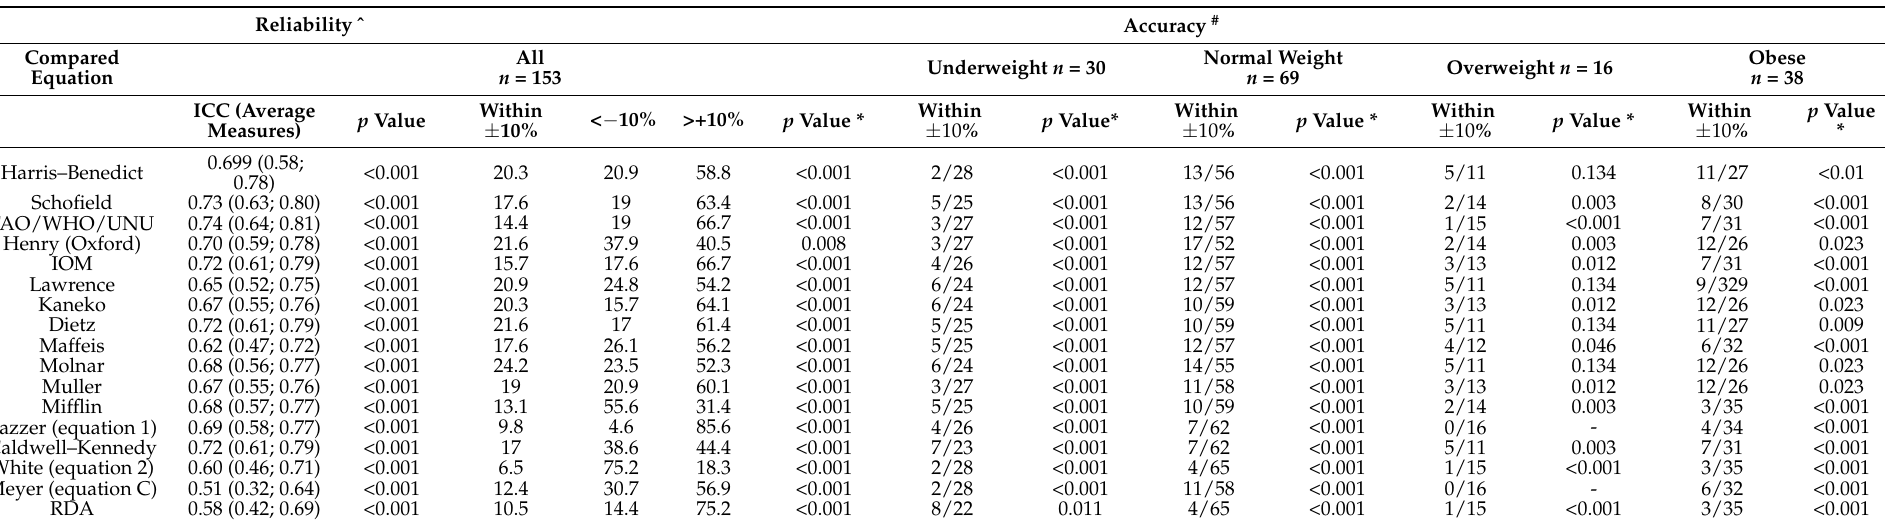
Table 3. Reliability by intraclass correlation coefficient (average measures) and 10% accuracy of the studied equations of predicted energy expenditure in comparison to the resting energy expenditure measured by indirect